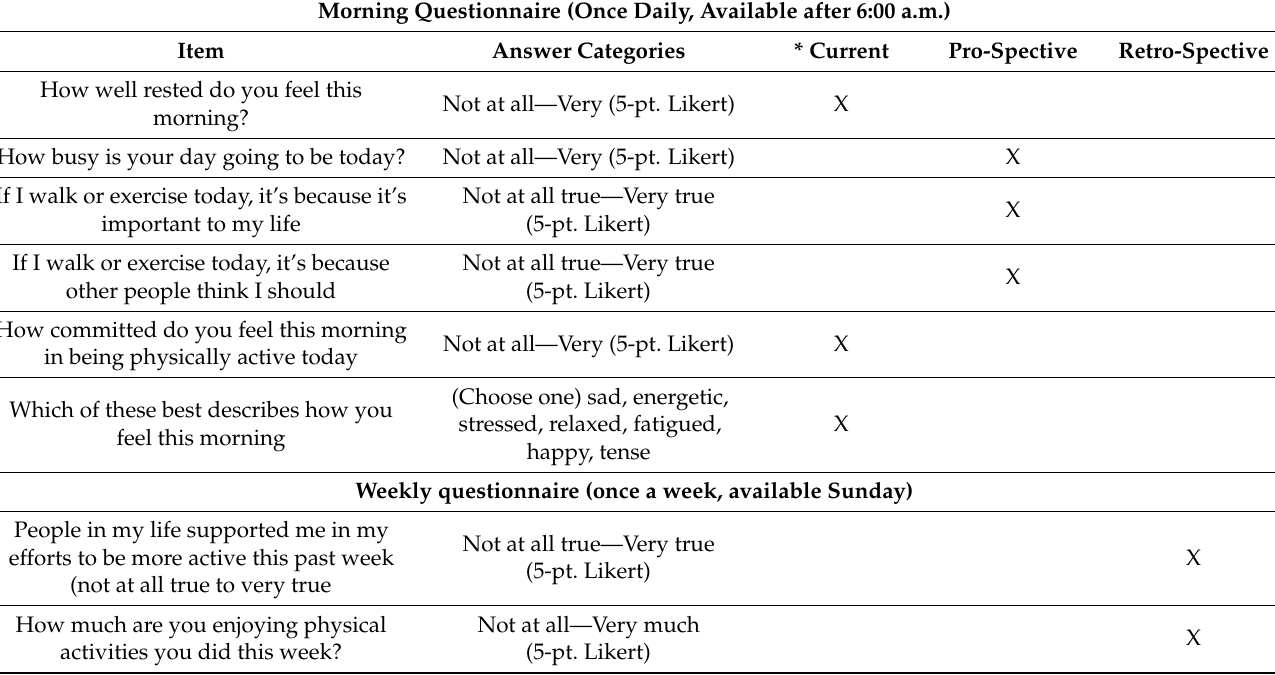
Table 2. Ecological Momentary Assessments and